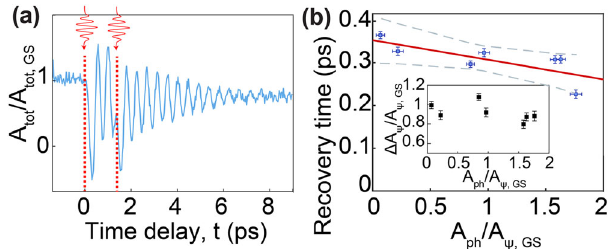
Fig. 4 Testing the hypothesis of the phonon-assisted electronic order formation by using two pump-pulses. a Typical time-resolved total = A displacement A normalized by its value in the ground state for two tot tot ; GS pump pulses arriving as indicated. The second pulse changes the phonon amplitude 29 . b The density wave recovery time, τ , as a function of the phonon amplitude, A ph = A ψ ; normalized by the order parameter in the GS ground state, both measured after the arrival of the second pump pulse. Fig. 3 Landau model of the electronic order parameter and its ordering (cid:1) (cid:3) Each pair of values is determined from a fi t to the data measured with a , as a function of the wavevector. a The Landau free-energy, F ψ ; Q m fi xed time delay between the two pump pulses; the analysis procedure is transient temperature of the electron gas, T e , and the order parameter ψ , identical to the analysis used for single-pulse data (see Eq. (1)), with taking shown for the wavevector Q m that minimizes the free-energy (color scale (cid:1) (cid:3) the arrival of the second pulse as time zero. The red line shows a linear fi t (cid:4) (cid:5) (cid:4) (cid:5) shown at the top). b The free-energy F ψ m ; Q as a function of the electronic ¼ b A þ c , with b ¼ (cid:1) 0 : 046 and c ¼ 0 : 35. = A with τ A ph = A ψ ; GS ψ ; GS ph temperature, T e , and wavevector Q , shown for the order parameter ψ m that The dashed gray lines indicate the prediction intervals of the fi t. Inset: The minimizes the energy (color scale shown at the top). In a and b , the equili- quench after the second pulse as a function of the phonon amplitude: the brium (gray dashed line) and non-equilibrium (red solid line) paths during second pulse induces the same quench independent of the phonon order formation are shown. c The wavevector dynamics revealed through amplitude. All pump-pump delays are larger than 0.5 ps, ensuring the measuring the satellite-peak intensity and position: in equilibrium, the spin electron-lattice equilibration completes before the second pulse arrives. density wave (SDW) forms with a smaller wavevector Q H and then transitions Both pump pulses have the same intensity, 1 mJ/cm 2 , which only partially to Q L via an abrupt ( fi rst-order) phase transition (consistent with the energy quenches the spin density barrier indicated by the gray dashed line in b . Out-of-equilibrium, the order immediately forms with Q L , bypassing the state at Q H (see red line in b ). d A schematic phonon distribution during the formation of the SDW: in equilibrium the SDW forms at the Néel temperature ( T lattice = T N , top, gray), and out-of-equilibrium the SDW forms at a lower lattice temperature T T lattice < N and in presence of wavevector-matched acoustic phonons at Q L (red, bottom).